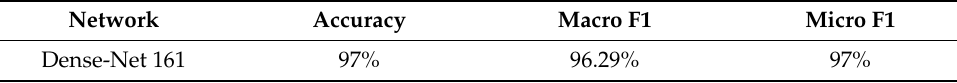
Table 11. The evaluation results of the first experiment on the PETA dataset.